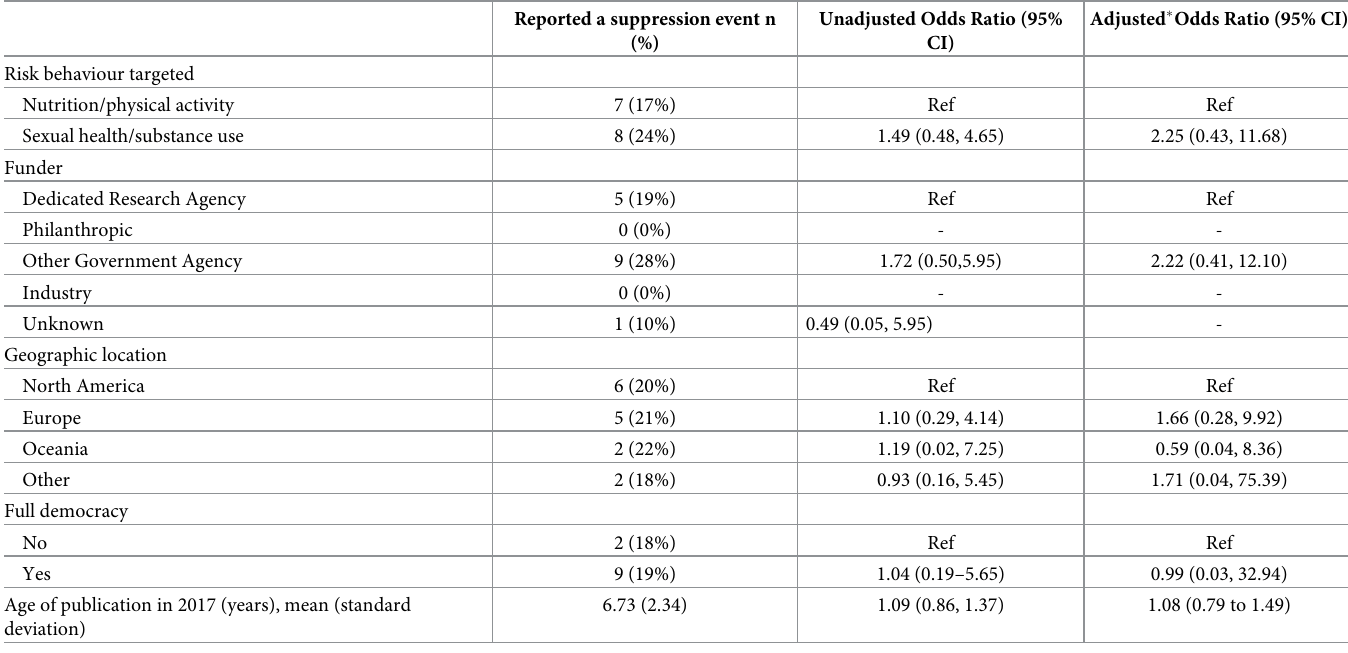
Table 2. Associations between trial characteristics and suppression